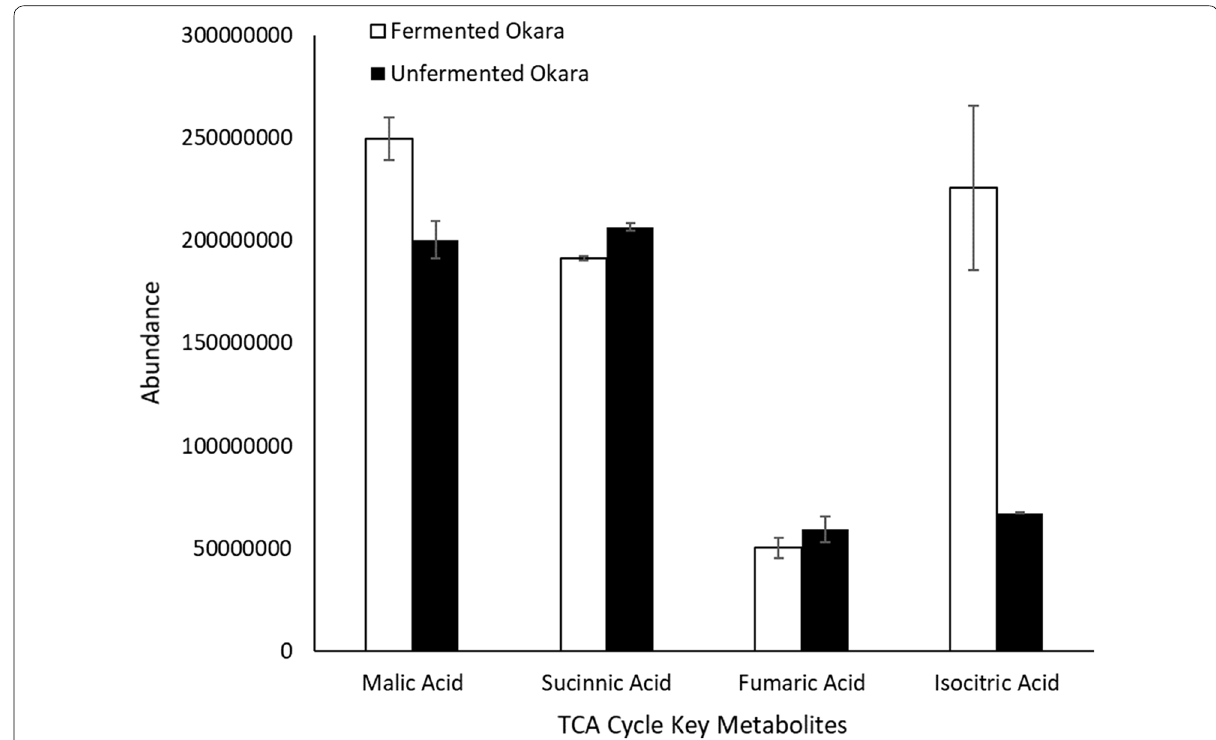
Fig. 4 Abundance of all the TCA cycle key metabolites detected